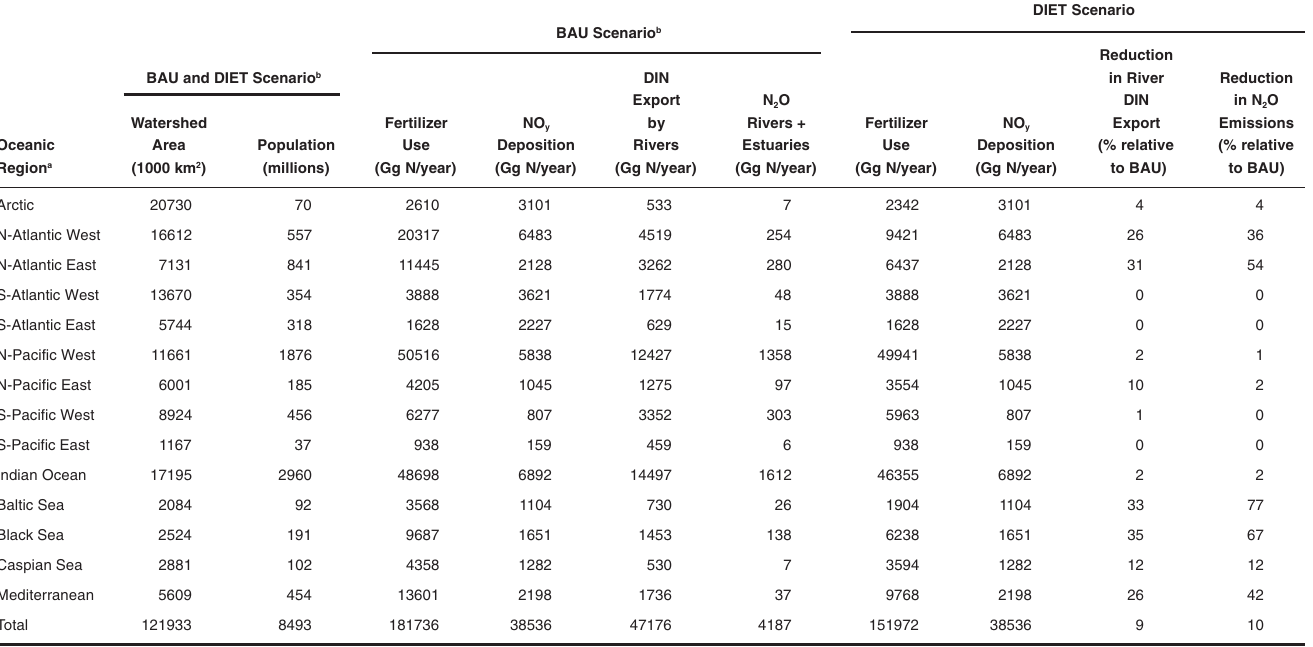
N-Model Inputs of Population, Fertilizer Use, and NO Deposition Rates in Exoreic y Watersheds, Summarized by Oceanic Region. Calculated DIN Export Rates by Rivers and Associated N O Emissions in Rivers and Estuaries, for Two Scenarios for 2